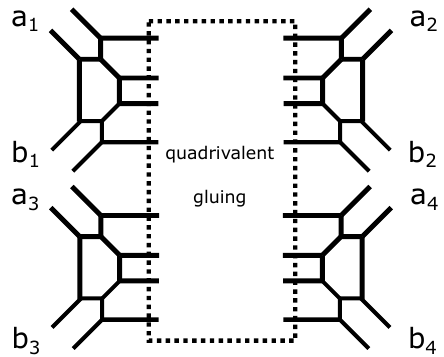
Figure 8. The labeling of [( a 1 , a 2 , a 3 , a 4 ) , ( b 1 , b 2 , b 3 , b 4 )] for each SU(2) in the web diagram in figure